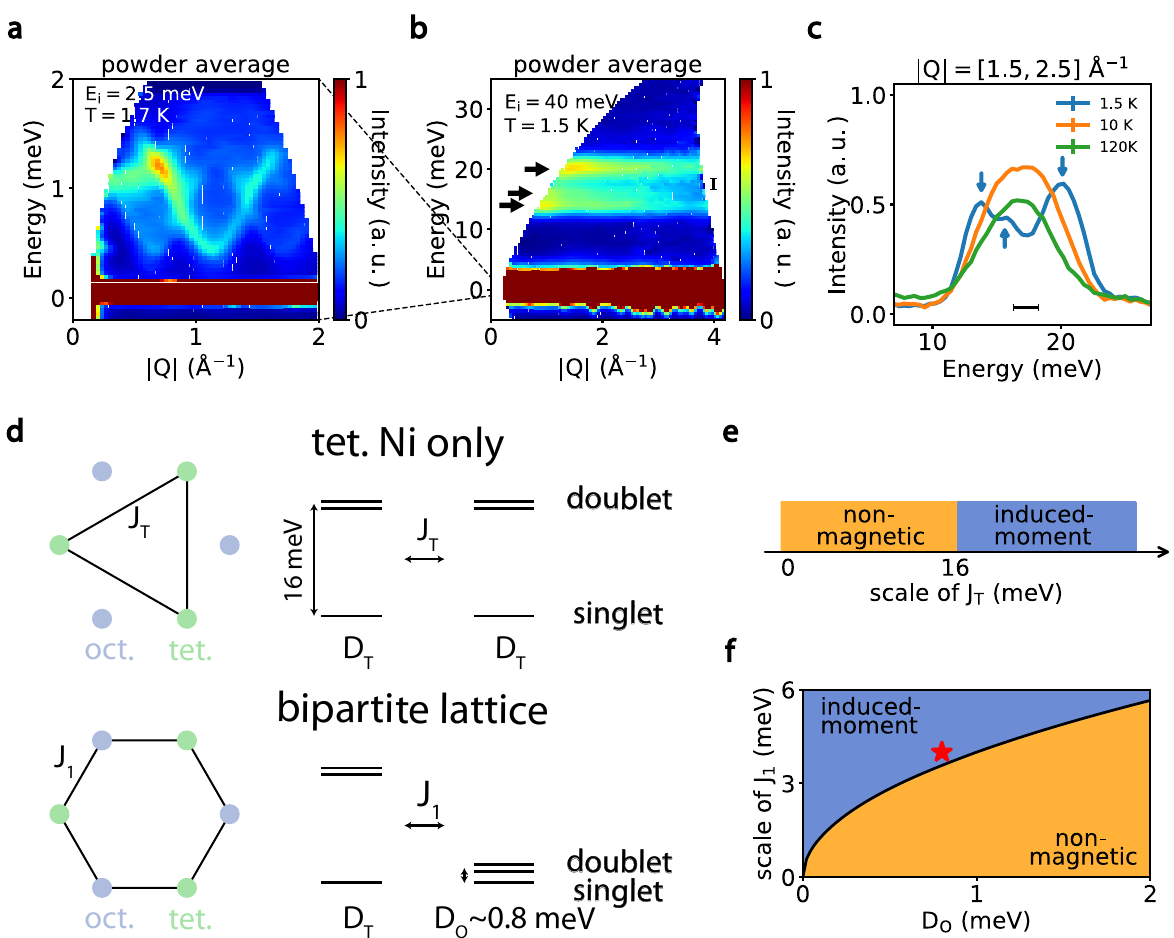
Fig. 2 | Powder inelastic neutron spectra and crystal fi eld levels of Ni 2 Mo 3 O 8 . a Powder average of the low-energy spin waves of Ni 2 Mo 3 O 8 single crystal at 1.7K with E i =2.5meV, which cannot be resolved in the spectrum using E i =40meV. b PowderaverageofthespinexcitationspectrumofNi 2 Mo 3 O 8 singlecrystalat1.5K with E i =40meV. Black arrows denote the three excitonic levels at 13.8, 16.9, and 20.3meV. c Temperature dependence of the constant- Q ([1.5 – 2.5] Å − 1 ) cuts at 1.5K from data in panel b . Blue arrows denote three peaks at 13.8, 16.9, and